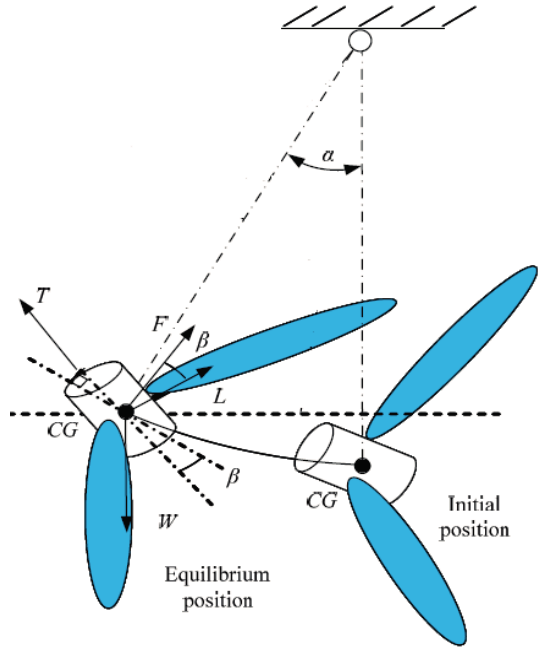
Figure 29. Force diagram of swing